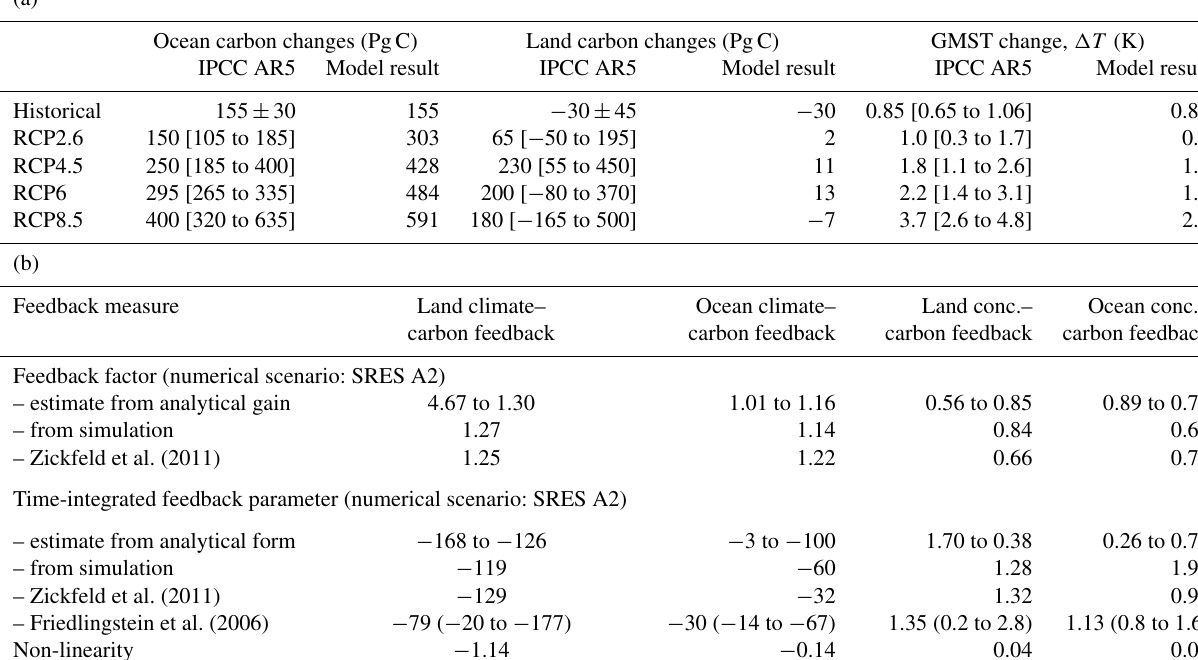
Table A2. Testing parameters fitted to historical data. The following changes to parameter values were made to those listed in Table 1: K C = on how the figures were calculated and sources for model comparison. (b) Feedback analysis. See Table 3 for further information. Analytical forms are omitted